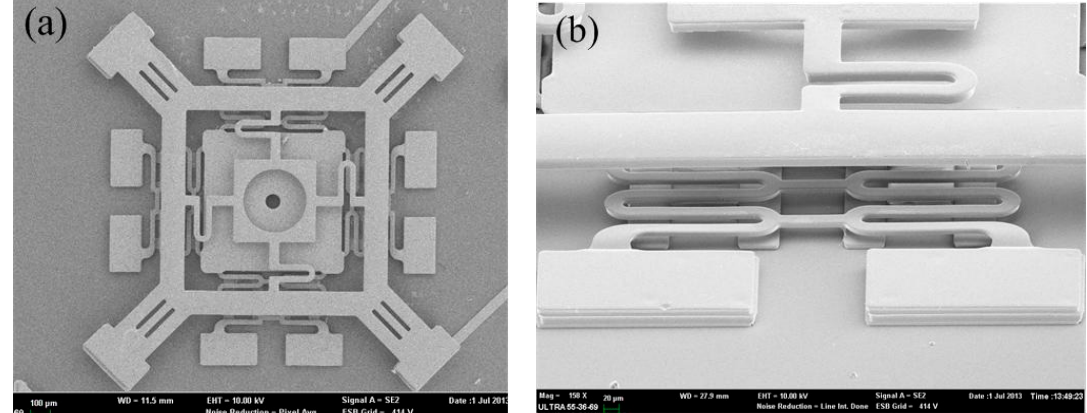
Figure 10. SEMs of the fabricated inertial micro-switch and a close-up. ( a ) The intact inertial micro-switch. ( b ) The suspended spring of the proof mass and stationary electrode cantilever.